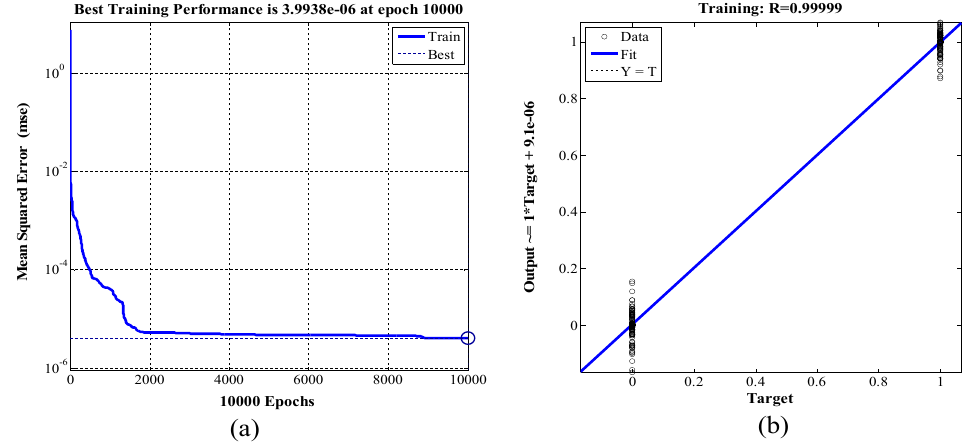
Figure 13. ( a ) Performance and ( b ) regression of ANN training after applying optimal parameters of ANN-PSO.